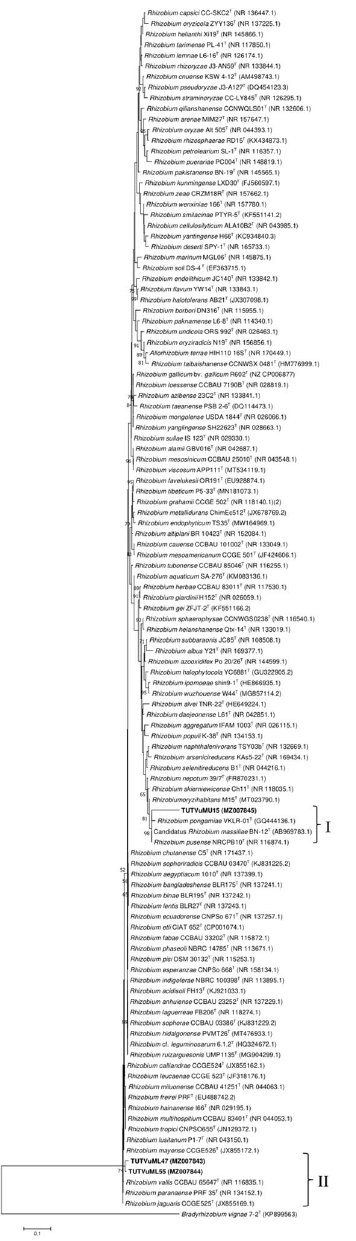
Figure 4. Maximum likelihood molecular phylogenetic analysis of native cowpea nodulating Rhizobium isolates from Mozambican soils based on 16S rRNA gene sequences. The aligned sequences were trimmed to a uniform length of 1127 bp for the construction of the phylogenetic tree. For each isolate and reference type strain, the accession numbers are indicated in